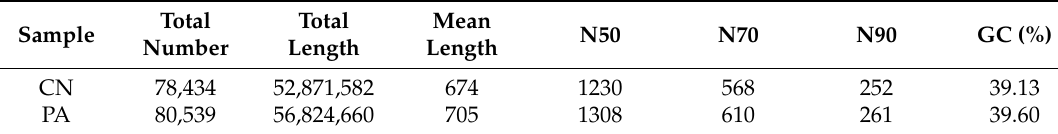
Table 2. Quality metrics of transcripts.